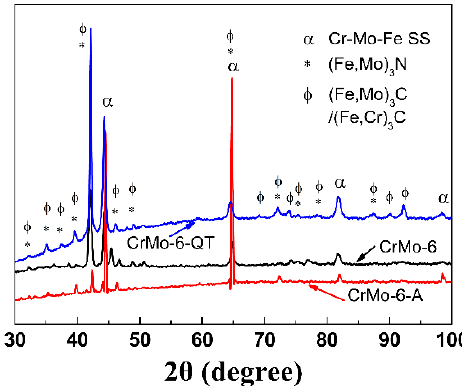
Figure 1. X-ray di ff raction (XRD) profiles of di ff erent Figure 1. X-ray diffraction (XRD) profiles of different samples.